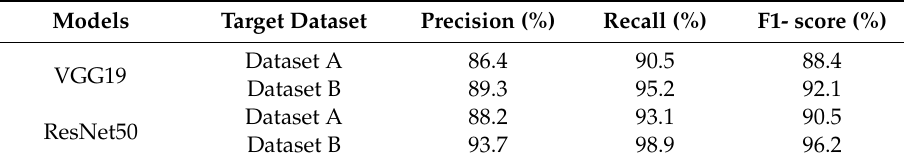
Table 5. Results of two target datasets with Scenario